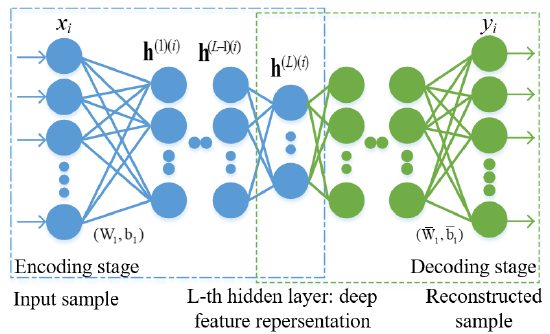
Figure 3. SSAE structure with three hidden layers in this